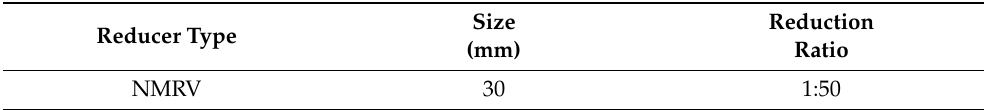
Table 4. Parameter table of matching